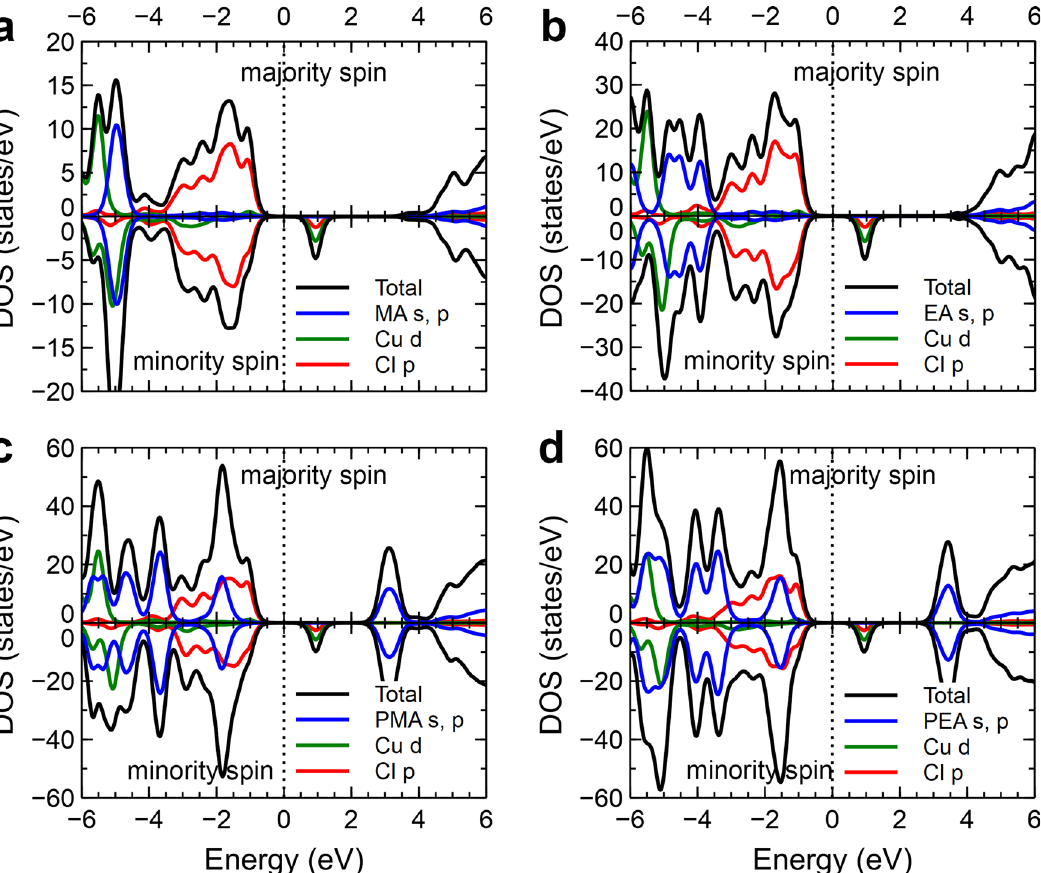
Fig. 7 Computed density of states of A 2 CuCl 4 compounds. (MA) 2 CuCl 4 ( a ), (EA) 2 CuCl 4 ( b ), (PMA) 2 CuCl 4 ( c ), and (PEA) 2 CuCl 4 ( d ), respectively. Total DOS (black), C 1 s and 2 p (blue), Cu 3 d (green), and Cl 3 p (red). Majority (minority) spin represent by the positive (negative)